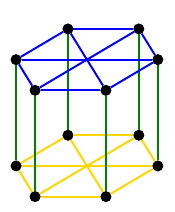
Fig. 1: The prism over K